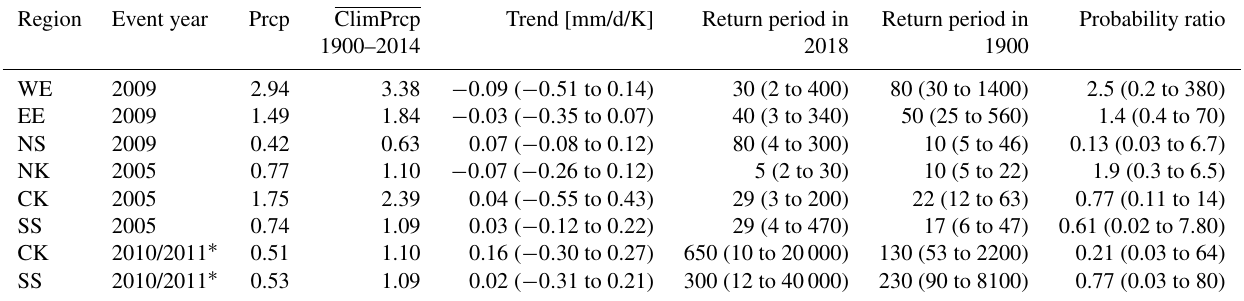
Table 4. Trends, return periods, and probability ratios of equivalent events in the year 2018 and 1900 for three recent drought events registered in the EM-dat database (2005, 2009, and 2010/2011), based on annual average precipitation (mm/d) from the CenTrends dataset. The 95% confidence intervals are given between brackets. For each study region impacted by the events, the annual precipitation for the event year (Prcp, used to define the event magnitude) and the 1900–2014 climatological precipitation average (ClimPrcp) is given. The asterisk ∗ denotes that July–June is taken instead of January–December to define a year.